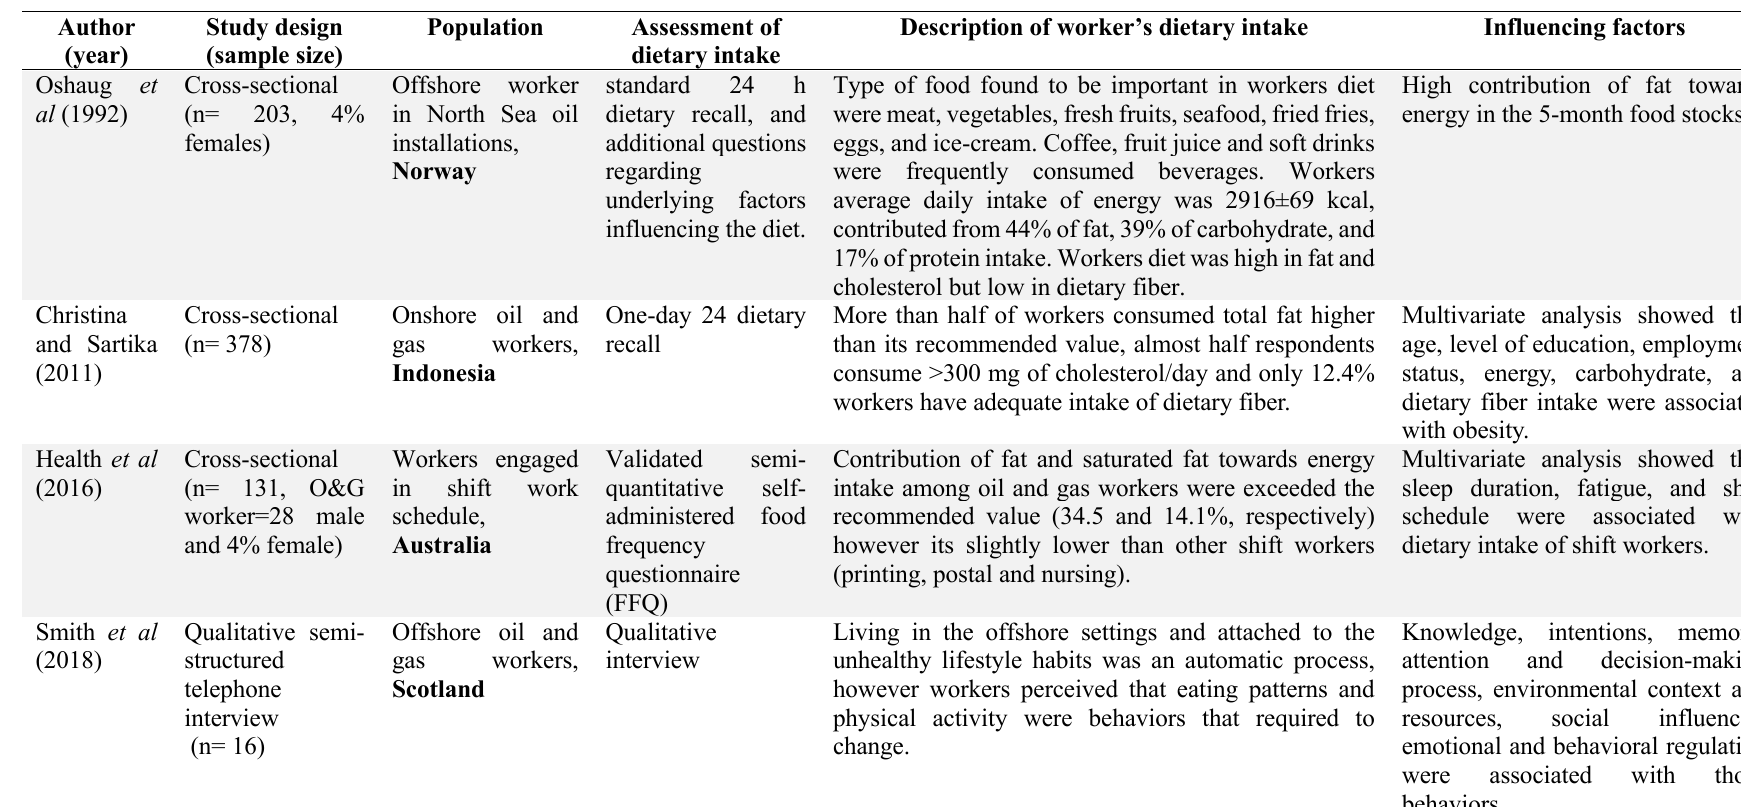
Table 1 . Studies exploring factors influencing diet, eating habits in oil and gas